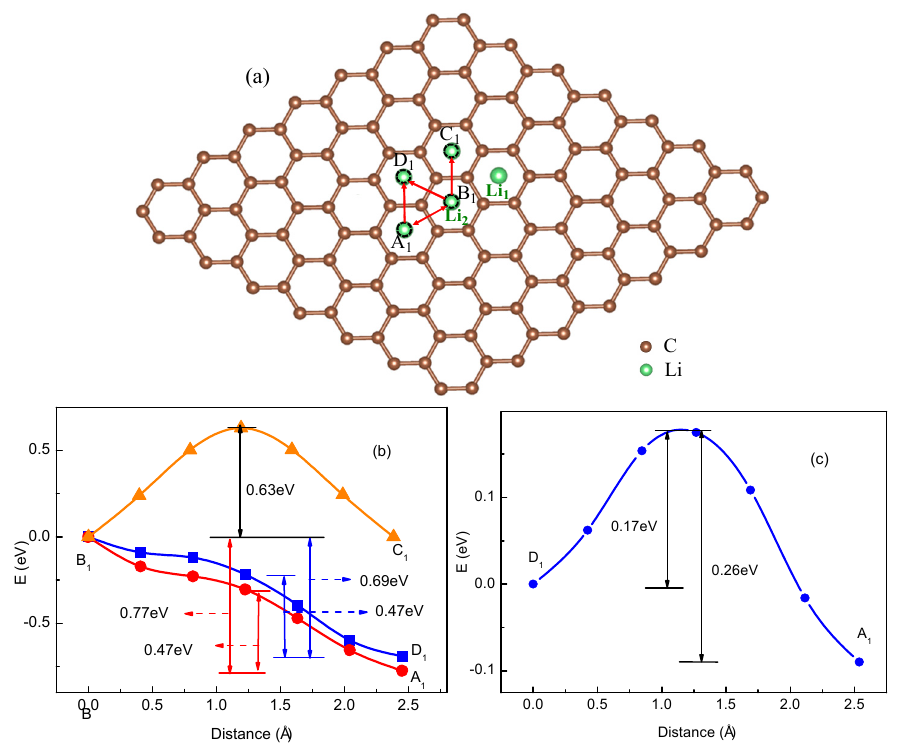
Figure 2. Schematic representations ( a ) and total energy curves for the system with two Li ions on graphene along ( b ) paths B 1 -C 1 , B 1 -A 1 and B 1 -D 1 ; ( c ) path D 1 -A 1 . Li +1 is migrating with Li +2 fixed.